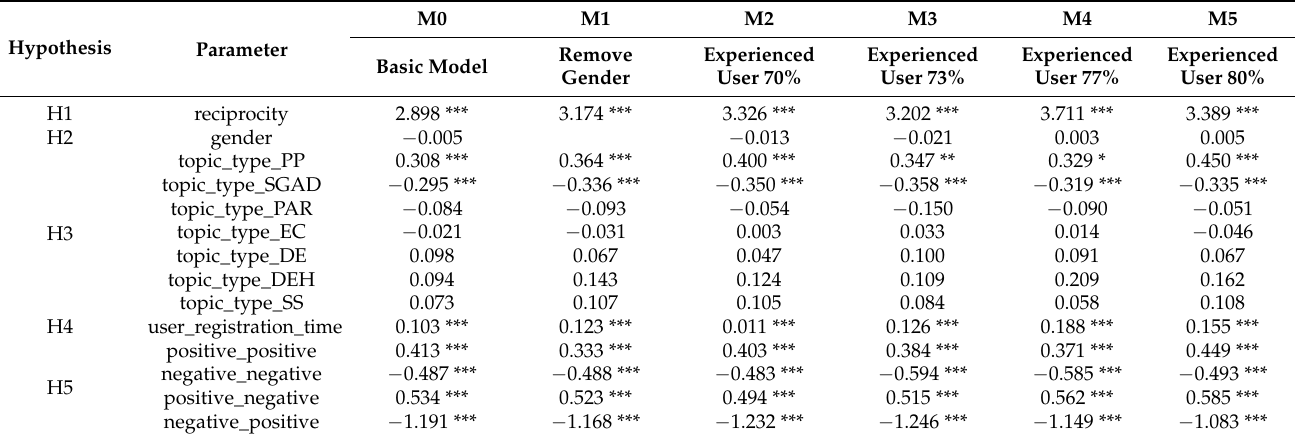
Table 4. Model robustness test